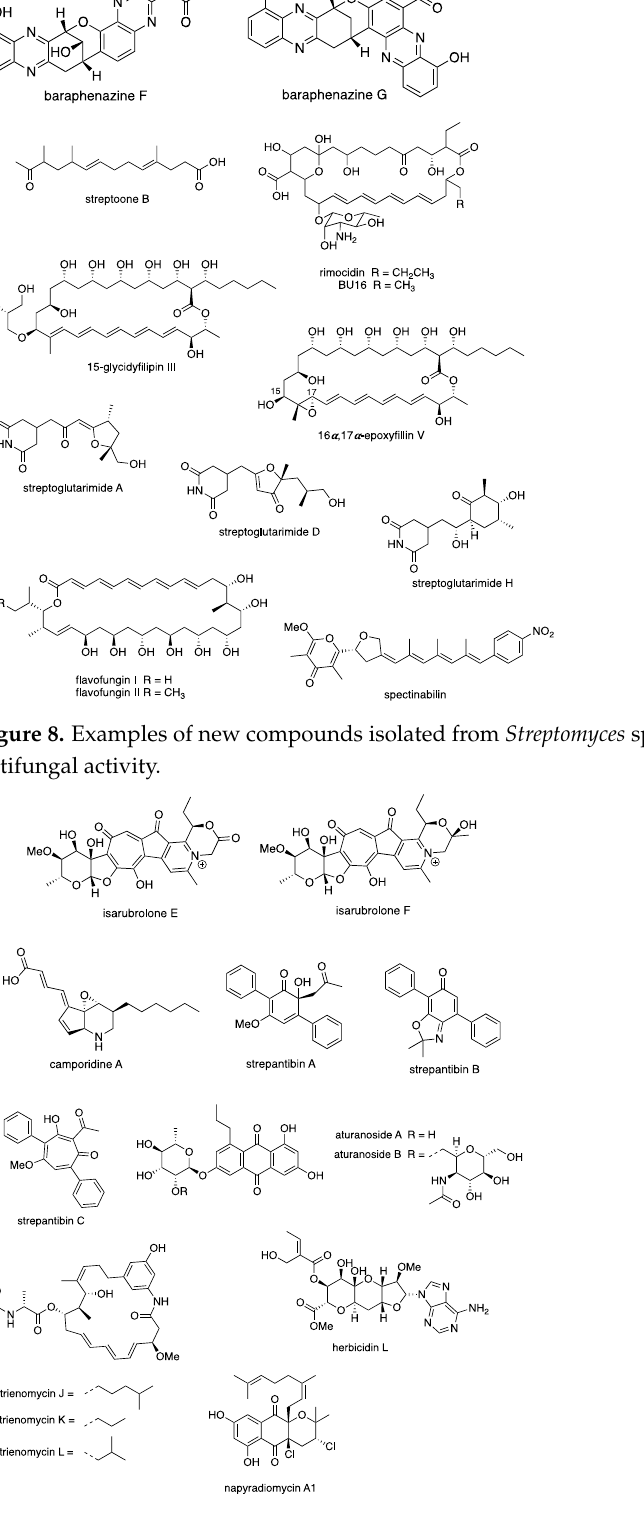
Figure 9. Examples of new compounds isolated from Streptomyces spp. between 2015 and 2020 with other biological activity.